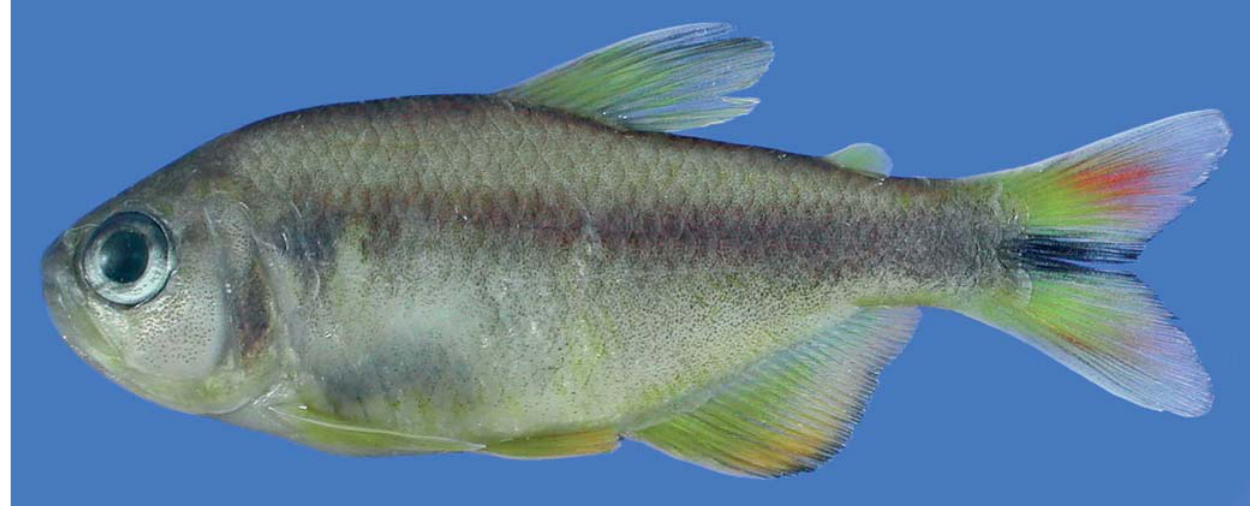
Fig. 3. Astyanax xavante , MZUSP 100376, 47.3 mm SL, paratype, from córrego Avoadeira, rio Araguaia basin, Barra do Garças, Mato Grosso (upon